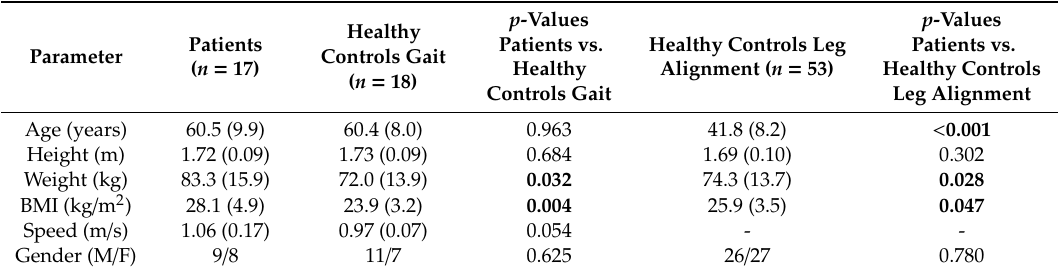
Table 1. Anthropometric data and walking